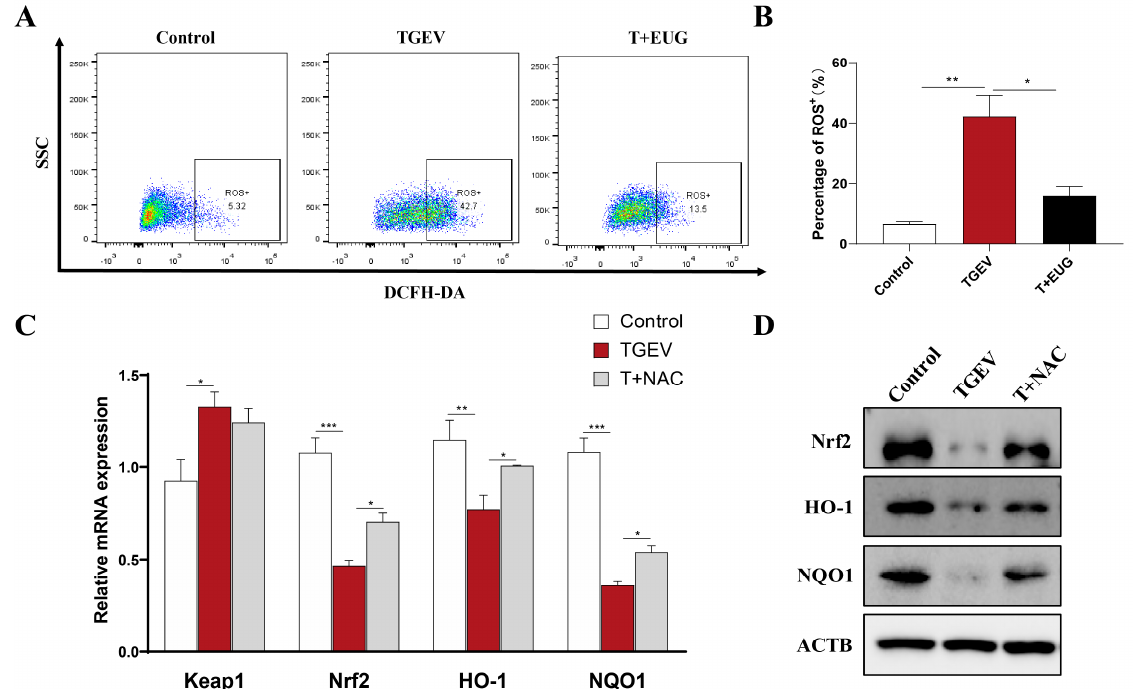
Figure 9. Eugenol relieves oxidative stress by removing ROS. IPEC-J2 cells were pretreated with eugenol (200 μ M) or NAC (5 mM) for 1 h and then infected with TGEV for 36 h. ( A , B ) The flow cytometry assays detecting ROS levels in IPEC-J2 cells; SSC means side scatter ( n = 3). ( C ) The expression of Keap1, Nrf2, HO-1 and NQO1 mRNA in IPEC-J2 cells were examined by RT-PCR ( n = 3). ( D ) Protein abundance of Nrf2, HO-1 and NQO1 in IPEC-J2 cells. Data are expressed as the mean ± SEM. * p < 0.05, ** p < 0.01, *** p < 0.001.